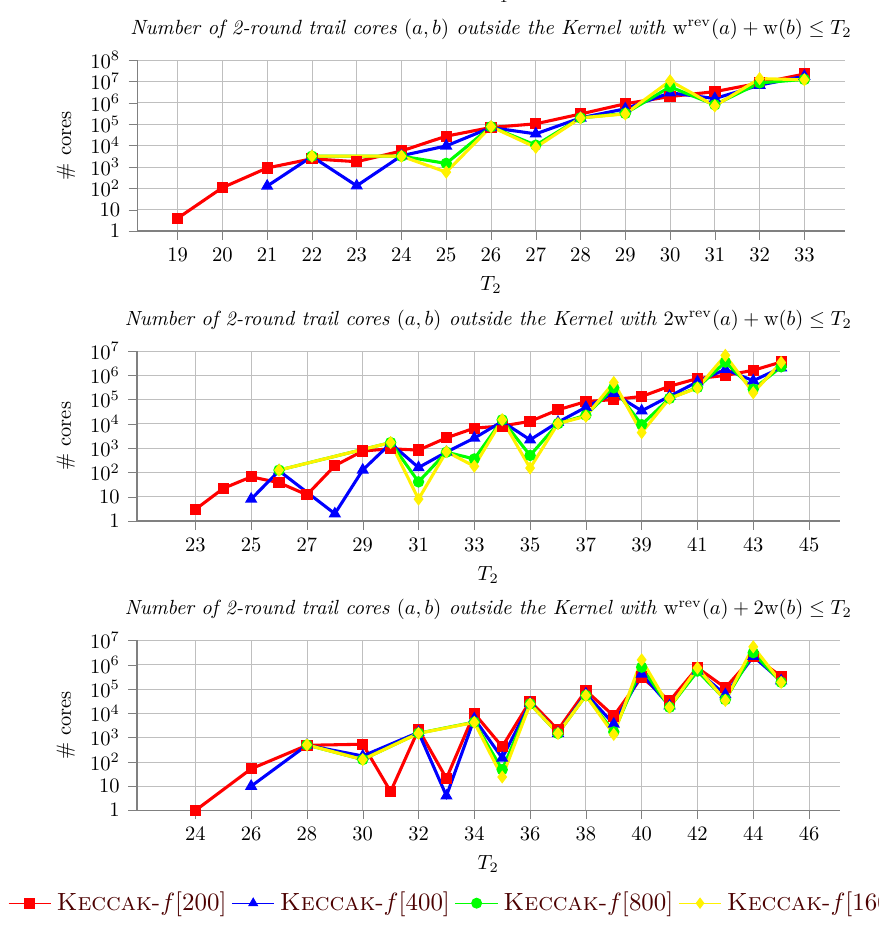
Figure 6: Number of 2-round trail cores for different cost